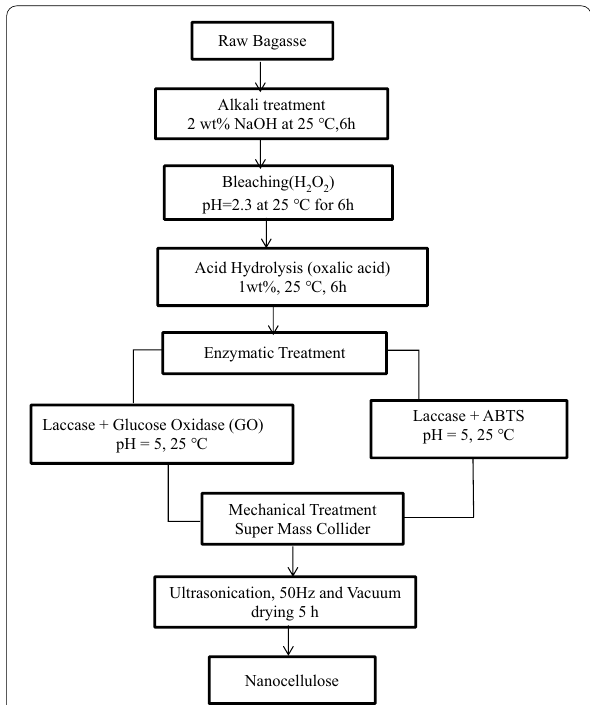
Fig. 1 Schematic representation of the nanocellulose